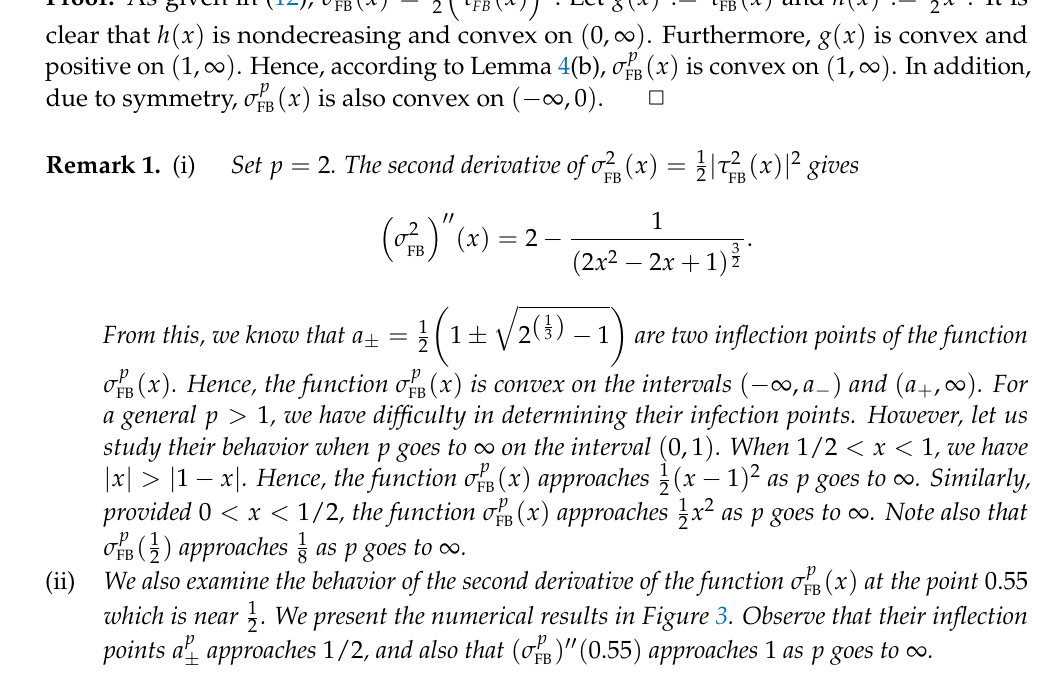
) (cid:48)(cid:48) ( 0.55 ) for different p FB